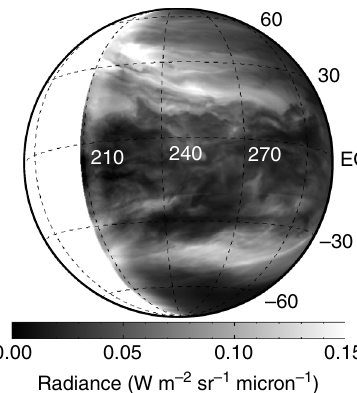
Fig. 1 Calibrated image of the night-side of Venus taken on 25 March 2016 07:33 UT by IR2, the 2- μ m camera, on board the Venus Climate Orbiter/ Akatsuki. Contrast features in the image are believed to re fl ect the opacity contrast of dense middle and lower clouds with a particle size of about 3.7 μ m (called mode 3) located around 49 – 57 km height. Note that the sub- spacecraft longitude and latitude are 246.0 deg. and − 9.1 deg.,